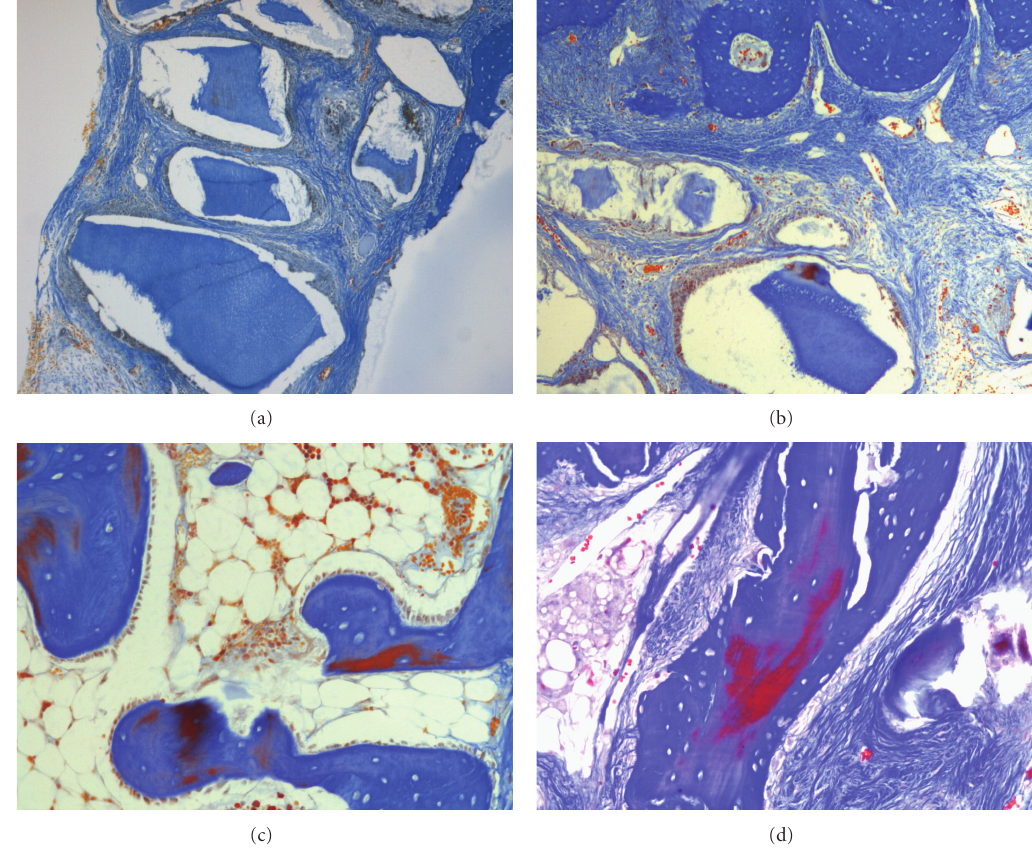
Figure 4: Mallory’s trichrome-stained histological sections of defect areas filled with (a) processed dentin product, 1 week post-op, original magnification × 10; (b) processed dentin product, 6 weeks post-op, original magnification × 10; (c) autogenous bone, 1 week post-op original magnification × 20; (d) autogenous bone, 6 weeks post-op, original magnification ×